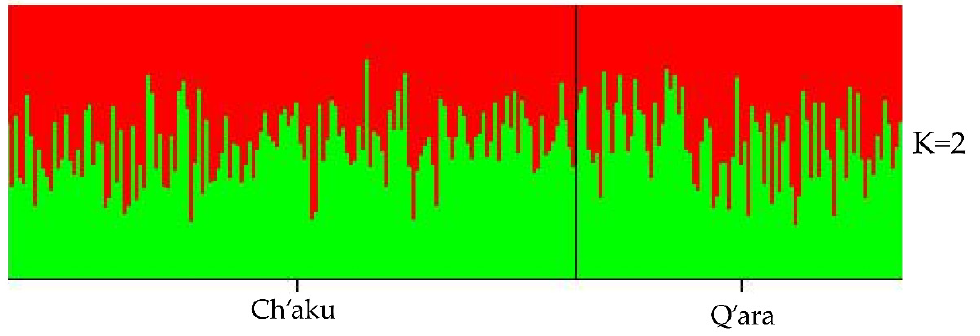
Figure 2. Structure analysis of the global llama population by cluster assignment using the Bayesian analysis (K = 2). The colored bars indicate the probability of assignment to either Cluster 1 (red) or 2 (green). The black line divides the Ch’aku and Q’ara subpopulations.